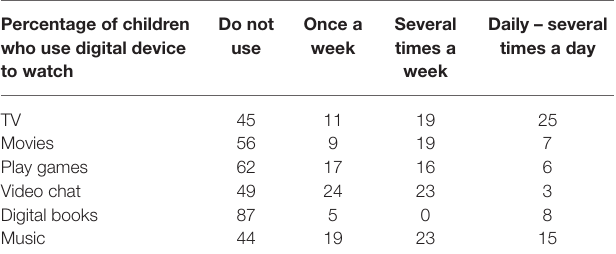
Percentage of children who use digital